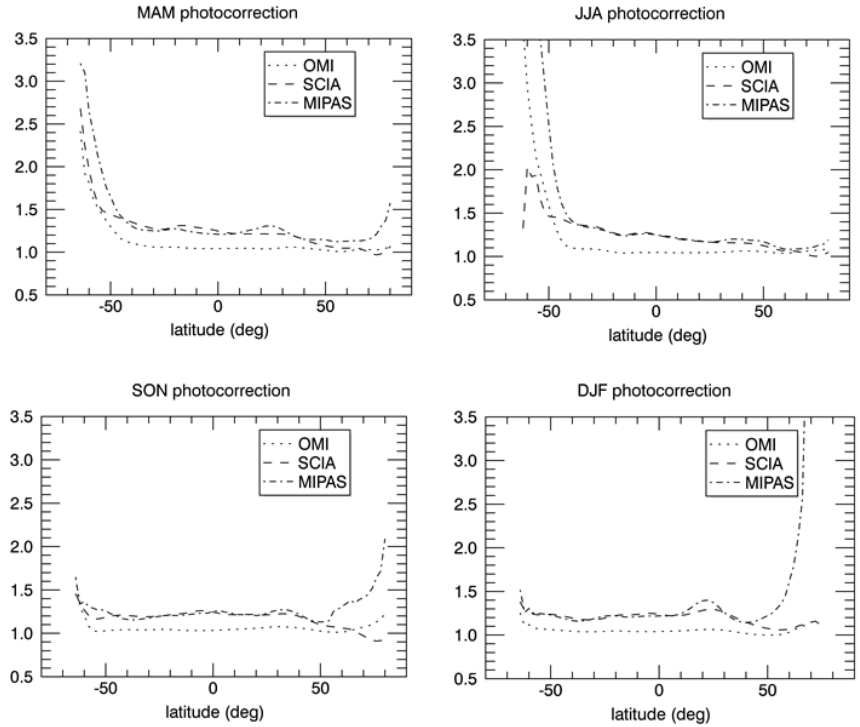
Figure 4. Seasonal average (MAM, JJA, SON and DJF) of OMI, MIPAS and SCIAMACHY column photocorrection (diurnal cycle correc- tion) factors plotted as a function of